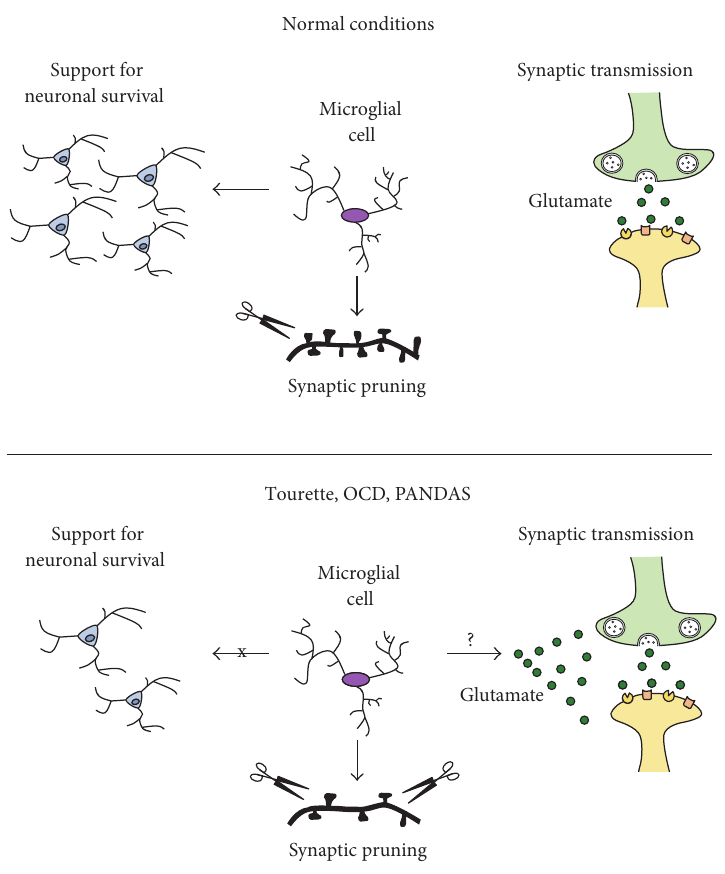
Figure 2: Possible mechanisms of abnormal microglial functions in OCD, Tourette syndrome, and PANDAS. Microglial cells support neuronal survival, and deficiencies in IGF-1 expressing microglia might lead to interneuronal loss (as observed in Tourette syndrome) or to abnormalities in synaptic pruning (as seen in animal models of GAS infection and excessive grooming). Microglial dysregulation may also lead to alterations in glutamate homeostasis, a phenomenon that occurs in